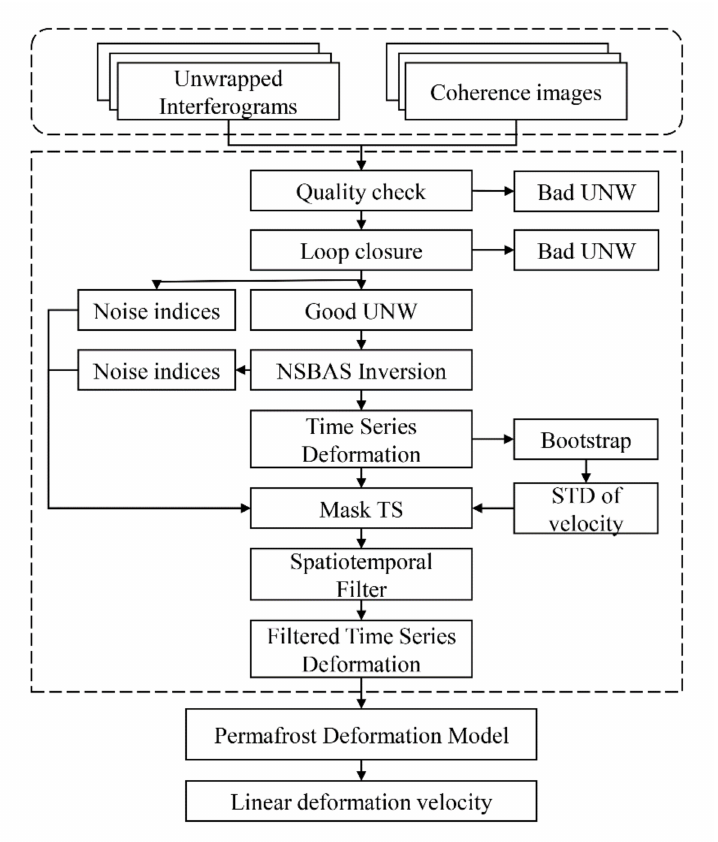
Figure 2. Flow chart of time-series InSAR processing in this